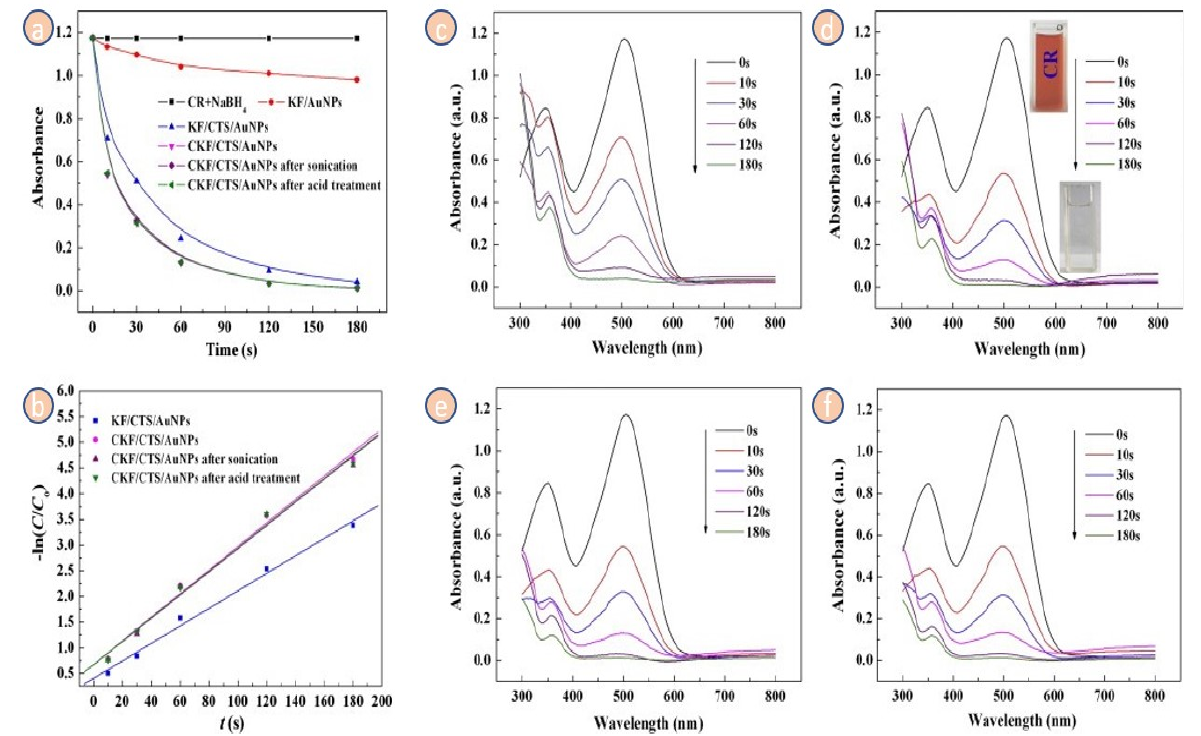
Figure 15. ( a ) KF/AuNPs, KF/CTS/AuNPs, and CKF/CTS/AuNPs catalytic kinetic profiles for CR process degradation; ( b ) linear correlation of ln(C/C0) per time t; ( c )Time-dependent UV–vis absorption wavelengths for the catalytic removal of CR by NaBH 4 in the existence of KF/CTS/AuNPs, CKF/CTS/AuNPs before ( d ), during, and after sonication ( e ), and after acid treatment with 1 mol/L HCl solution ( f ). Reprinted with permission from Ref. [128]. Copyright 2014, copyright Elsevier.